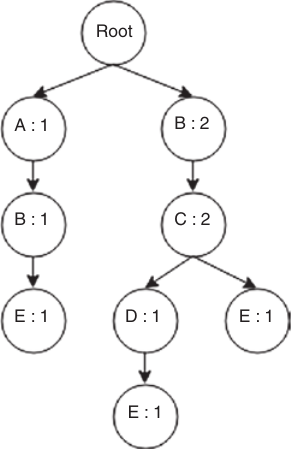
Figure 6: T-index for db transactions TI